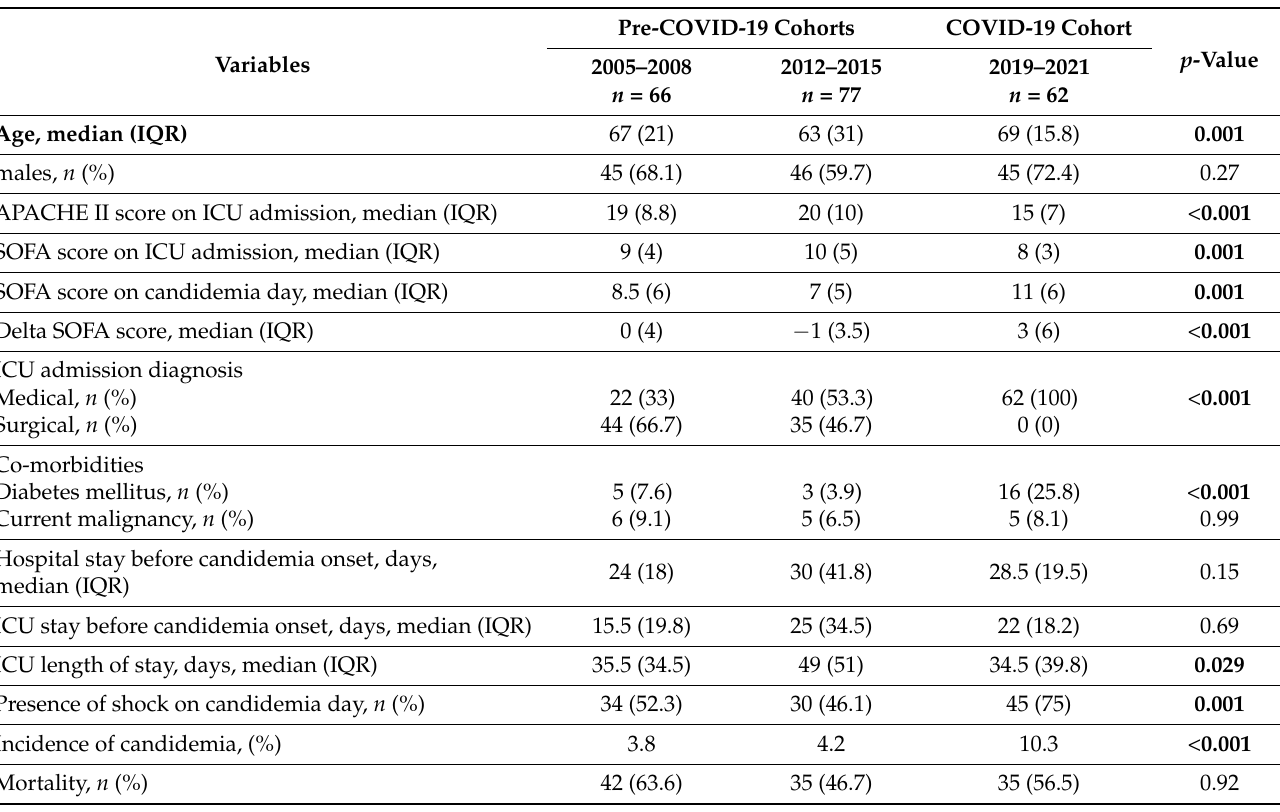
Table 1. Characteristics of ICU patients with candidemia in the three candidemia